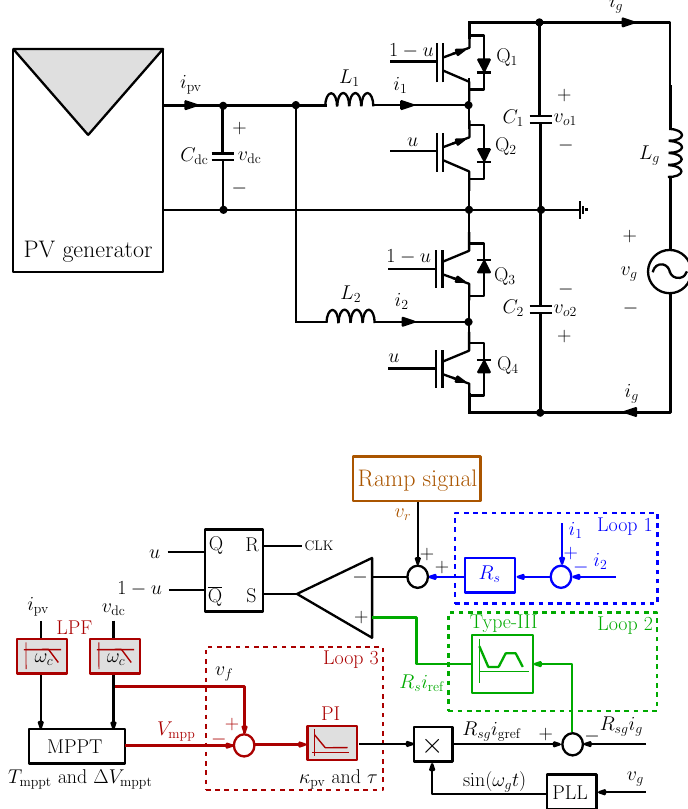
Figure 1. Single-stage grid-tied PV-fed differential boost AC